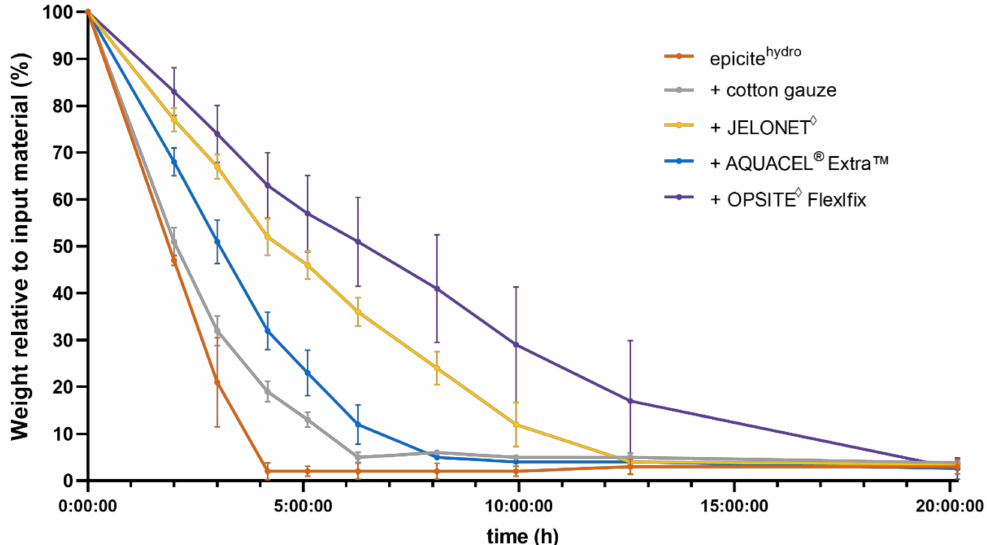
Figure 1. In vitro evaporation from epicite hydro in combination with different secondary dressings. Weight of epicite hydro , relative to initial weight, after incubation at 32 ◦ C for each timepoint. The BNC fleece was incubated without any coverage (orange) and with epicite hydro + cotton gauze (grey), ♦ epicite hydro + JELONET (yellow), epicite hydro + AQUACEL ® Extra ™ (blue), and epicite hydro + ♦ OPSITE Flexifix